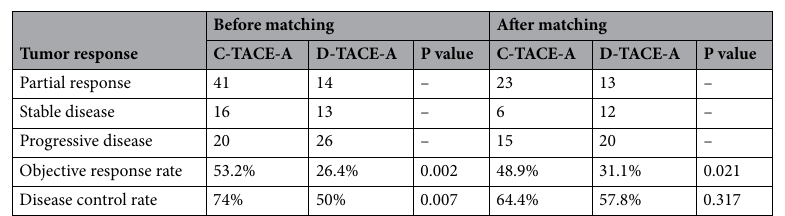
Before matching After Tumor response